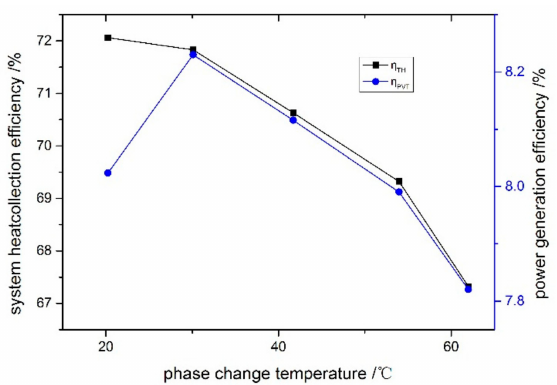
Figure 9. Curve of system heat collection e ffi ciency and power generation e ffi ciency with phase transition temperature.